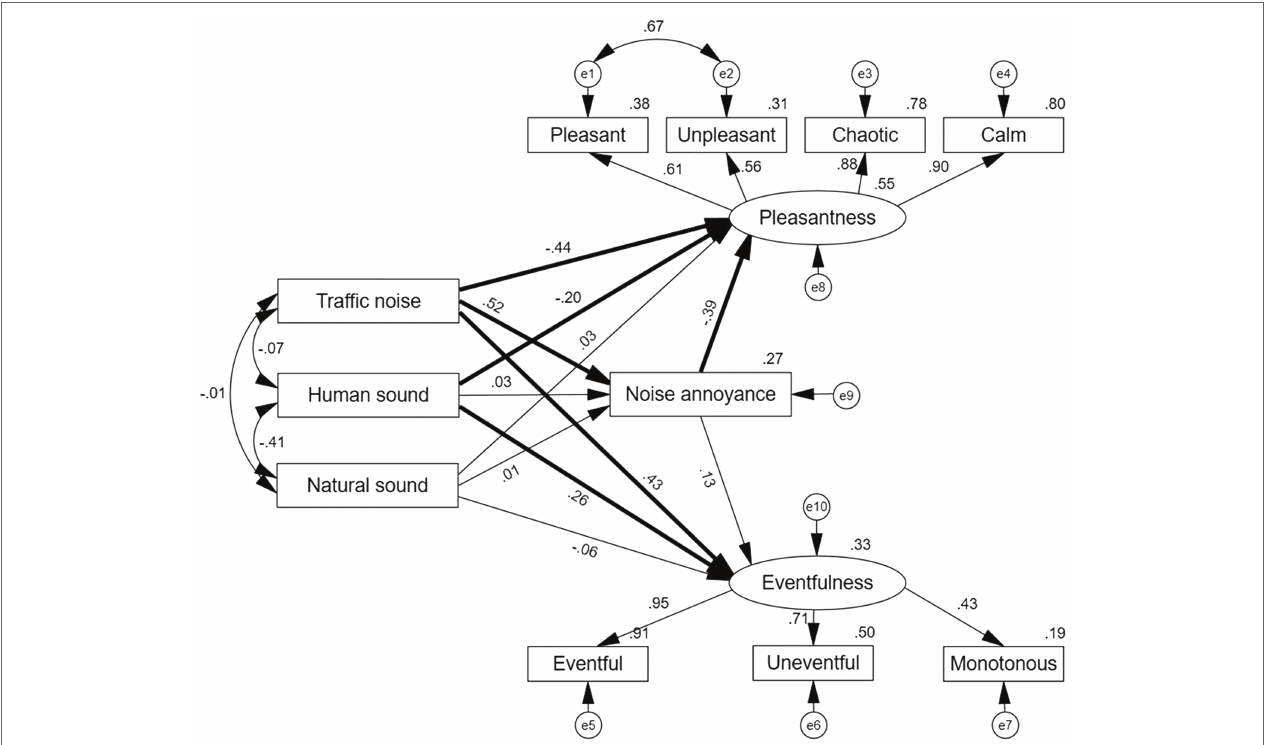
FIGURE 9 | Multigroup analysis in the SEM for the open community ( N = 210). The presented coefficients are standardized. e, error term, residue term; bold line, significant; and thin line, non-significant.